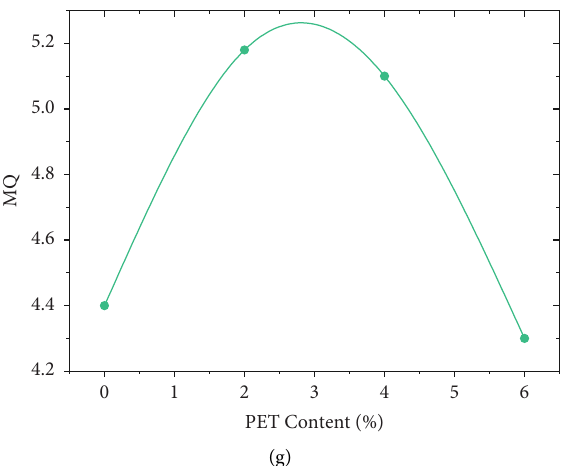
Figure 3: Properties of the PET modifed asphalt mix: (a) stability (KN), (b) fow, (c) bulk SG (Gmb), (d) air void, (e) VMA, (f) VFB, and (g) Marshall